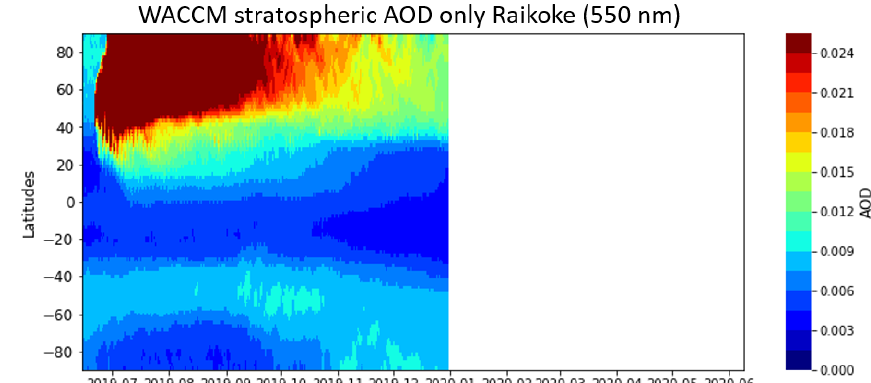
Figure B1. The integrated stratospheric column for the WACCM simulation for the Raikoke eruption, respective to Fig. 5b and c.